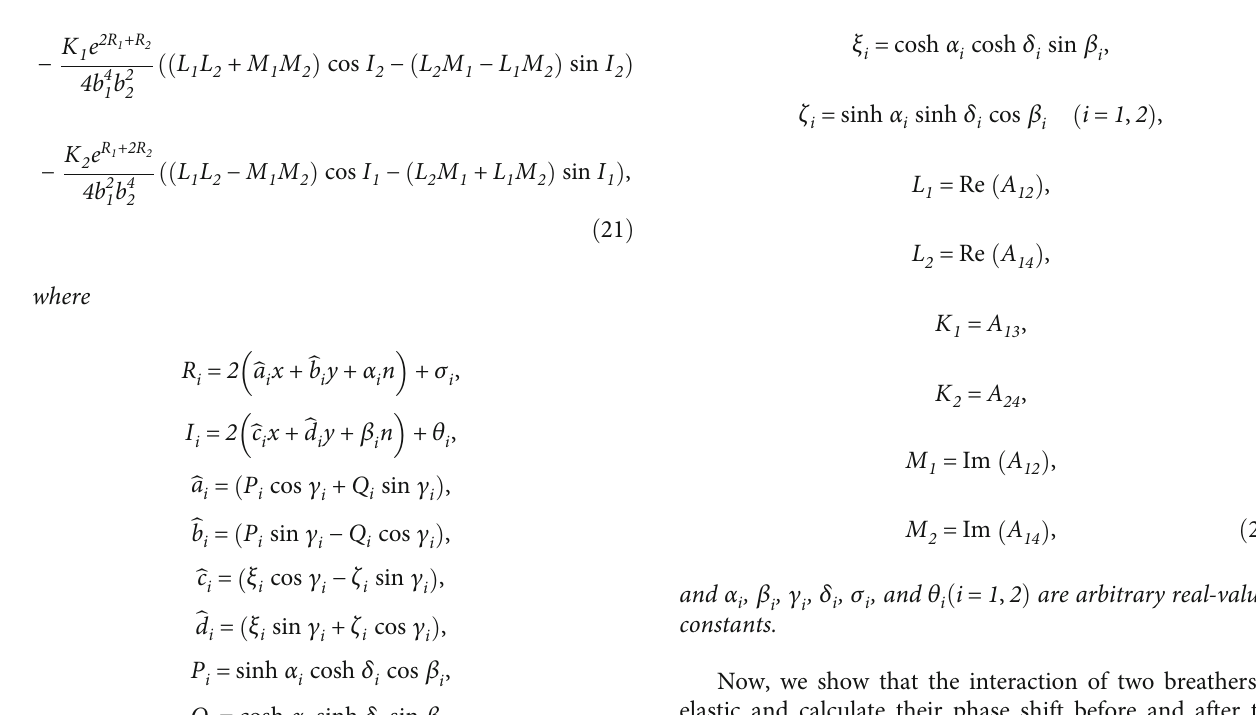
Figure 6: Propagation of hybrid solution composed of two line solitons and one lump at di ff erent times: (a) n = − 10 , (b) n = 0 , and (c) n = 10